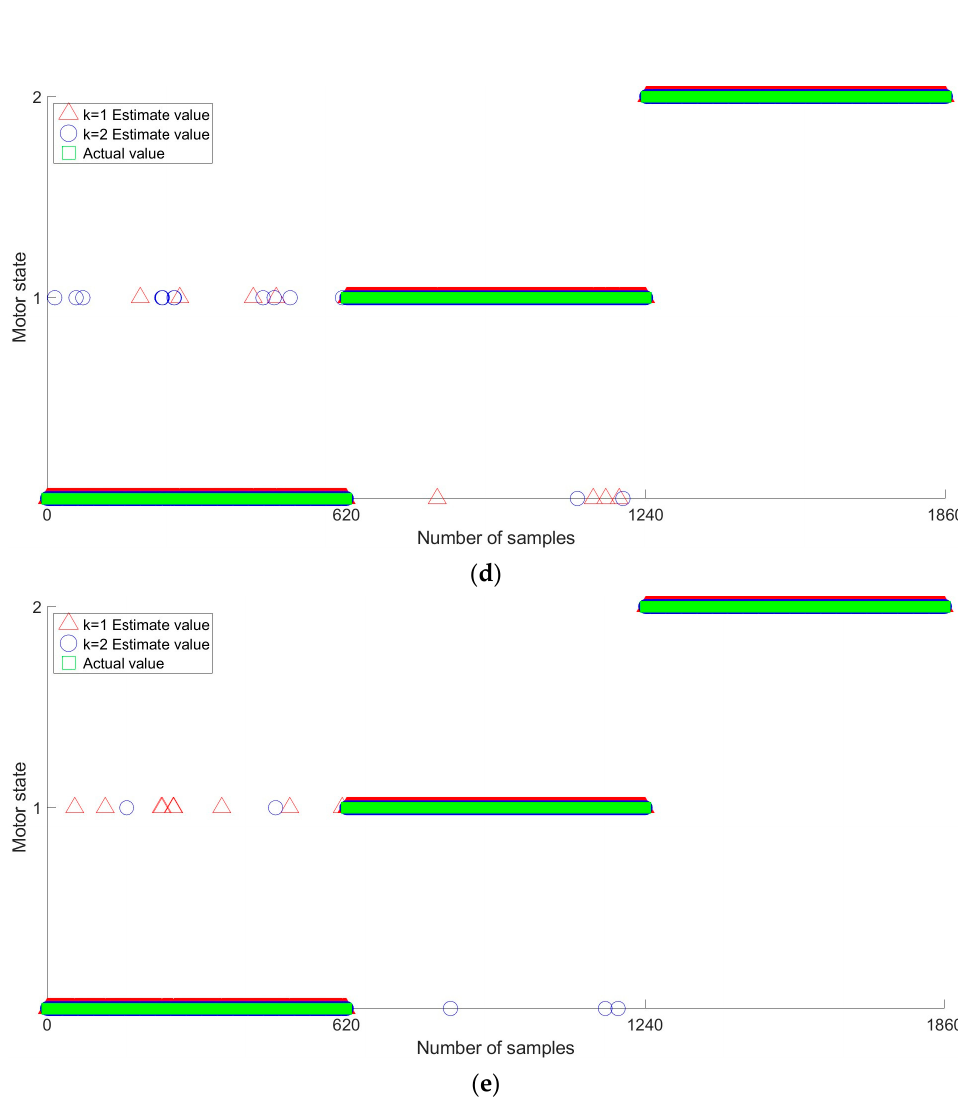
Figure 12. Results of the fault diagnosis using the optimal SVM, MNN, CNN, GBM, and XGBoost models. ( a ) Fault diagnosis result of the optimal support vector machine (SVM) model. ( b ) Fault diagnosis result of multilayer neural network (MNN) model. ( c ) Fault diagnosis result of convolutional neural network (CNN) model. ( d ) Fault diagnosis result of the optimal gradient boosting machine (GBM) model. ( e ) Fault diagnosis result of the optimal XGBoost model.